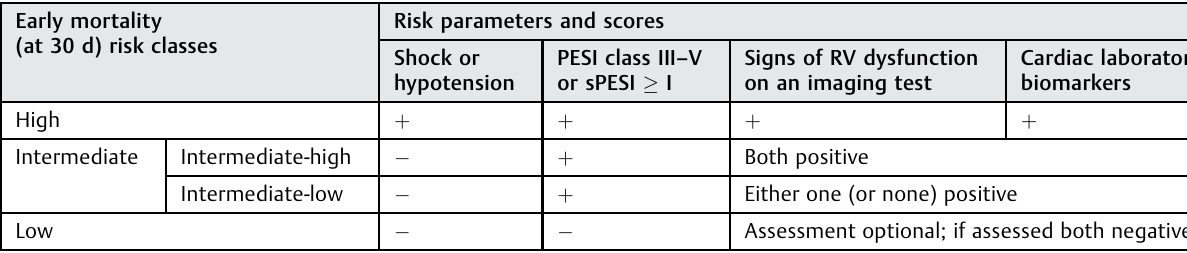
Table 1 Strati fi cation algorithm for early mortality in patients with acute pulmonary embolism Early mortality (at 30 d) risk